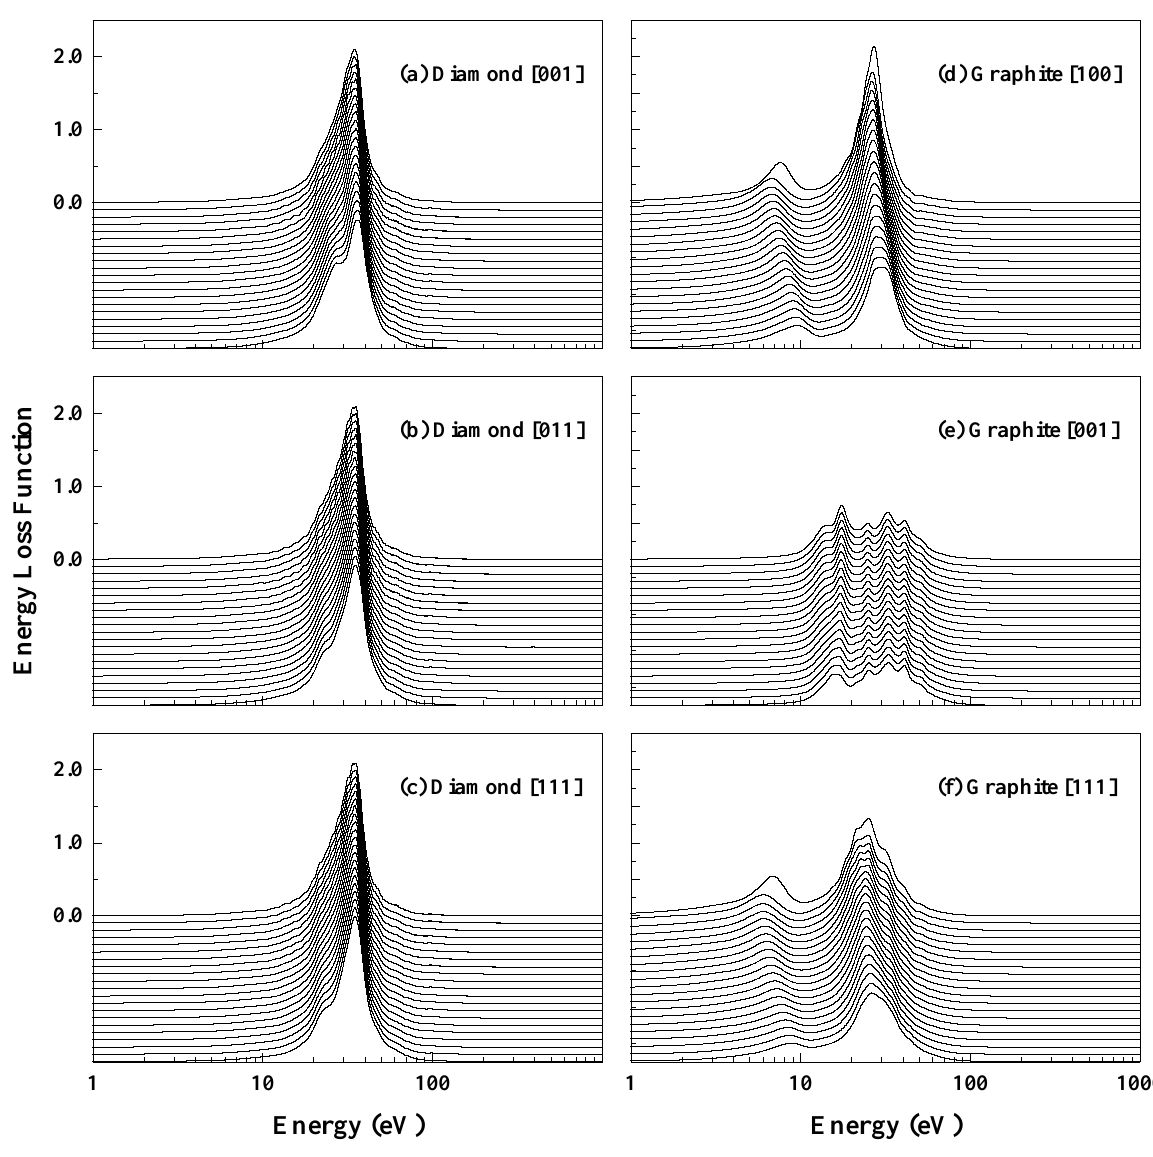
Figure 3. q -dependent energy loss functions for the [001], [011], and [111] directions of diamond and the [100], [100], and [111] directions of graphite. For clarity, zero on energy loss axis coincides with the energy loss function calculated for | q | ≈ 0.01 Å − 1 (0.005 × 2 π / a ). Successive energy loss functions for increasing q-values have been moved downward to | q | ≈ 1.00 Å − 1 (0.405 × 2 π / a ) in decrements of 0.02 × 2 π / a